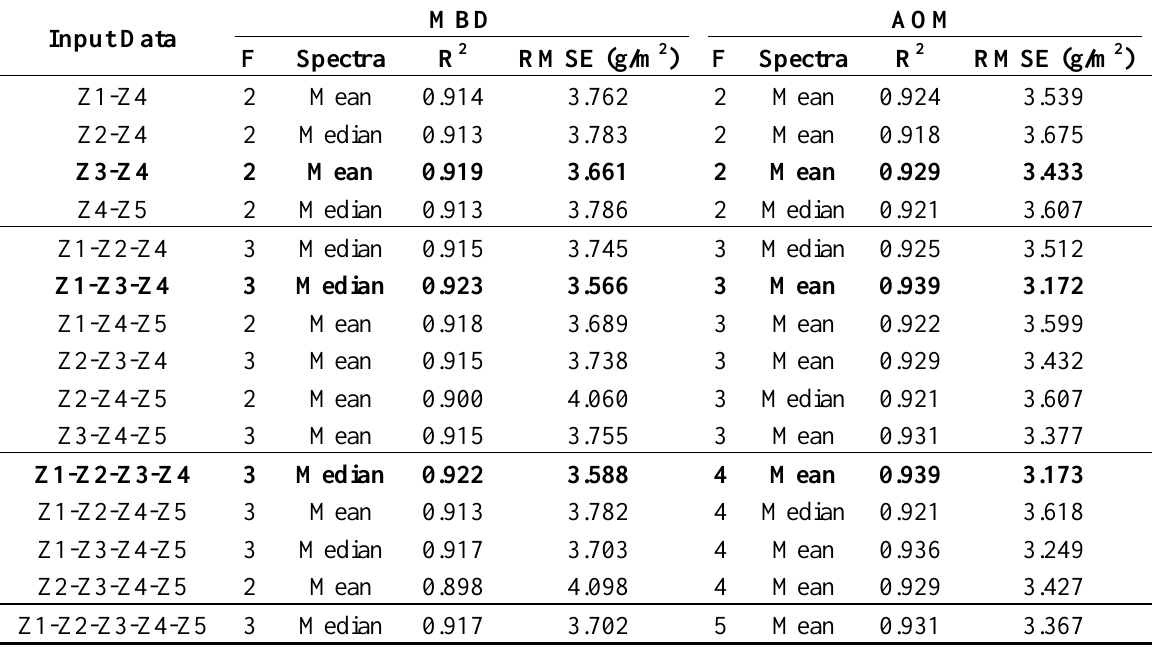
Table 9. Performance of PLSR for predicting green (GAGB) grass/clover biomass using indices which consider the absorption feature Z4 derived from the continuum removed spectra. In bold: most accurate